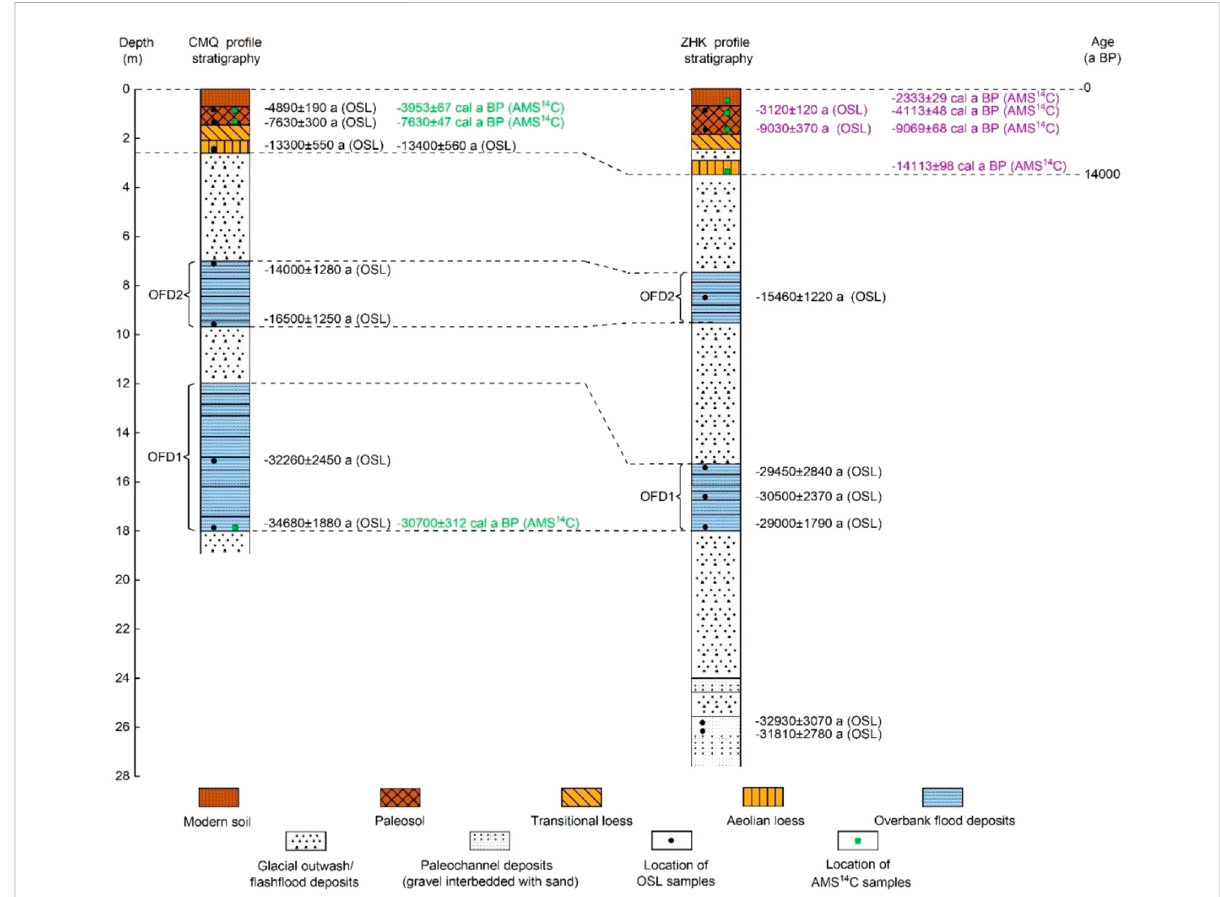
FIGURE 10 Pedo-stratigraphy and chronostratigraphic framework of the CMQ and ZHK pro fi les in the Yellow River source area on the NE Tibetan Plateau. [The dating data indicated in purple is taken from Jia et al.